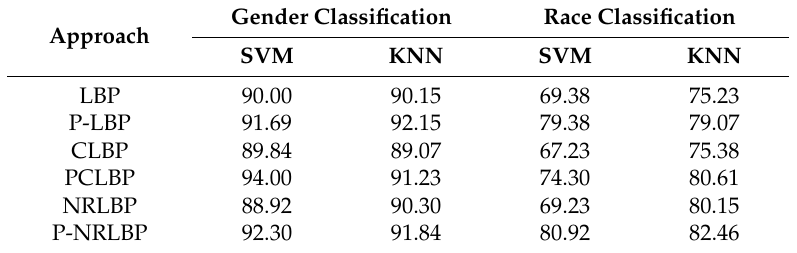
Table 4. Classification Rates for Gender for YVCb (PICS database).